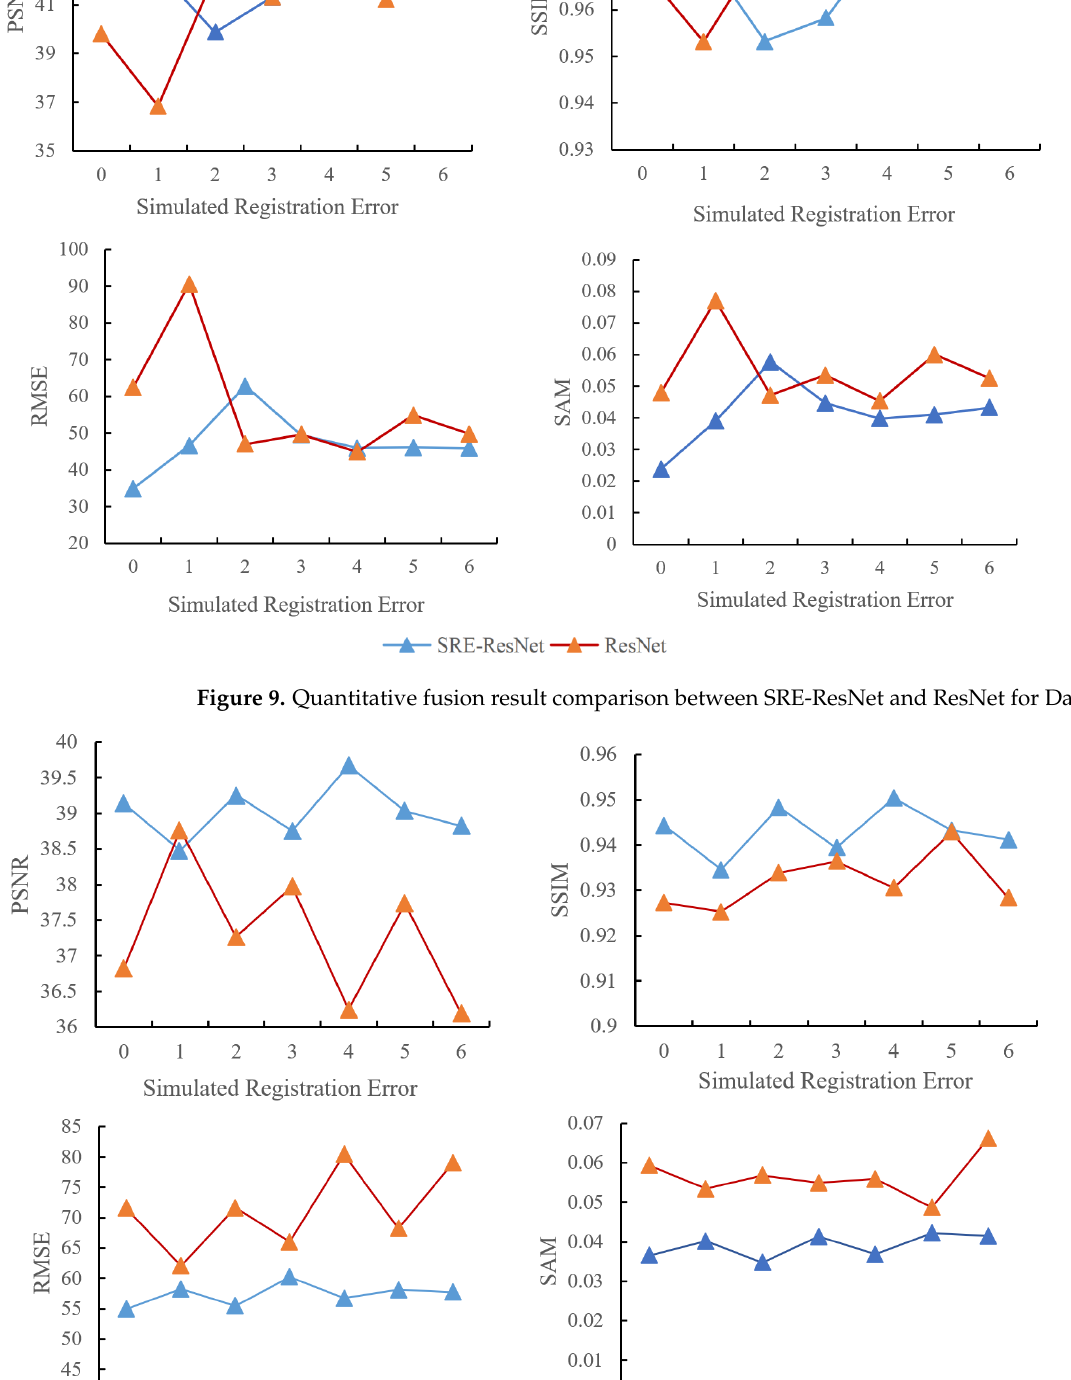
Figure 10. Quantitative fusion result comparison between SRE-ResNet and ResNet for Dataset II.